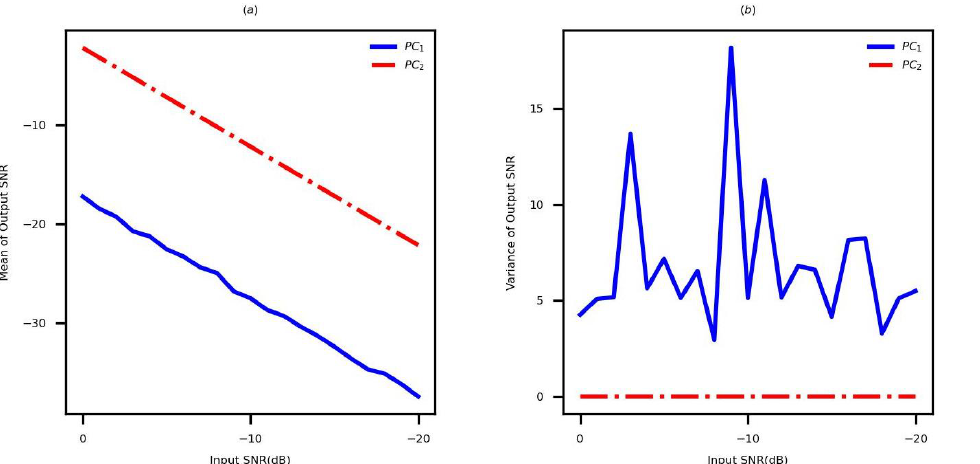
Figure 7. A comparison of the SNRs of HRRP generated by the existing method and the proposed methods. ( a ) The mean of HRRP’s SNR. ( b ) The variance of HRRP’s